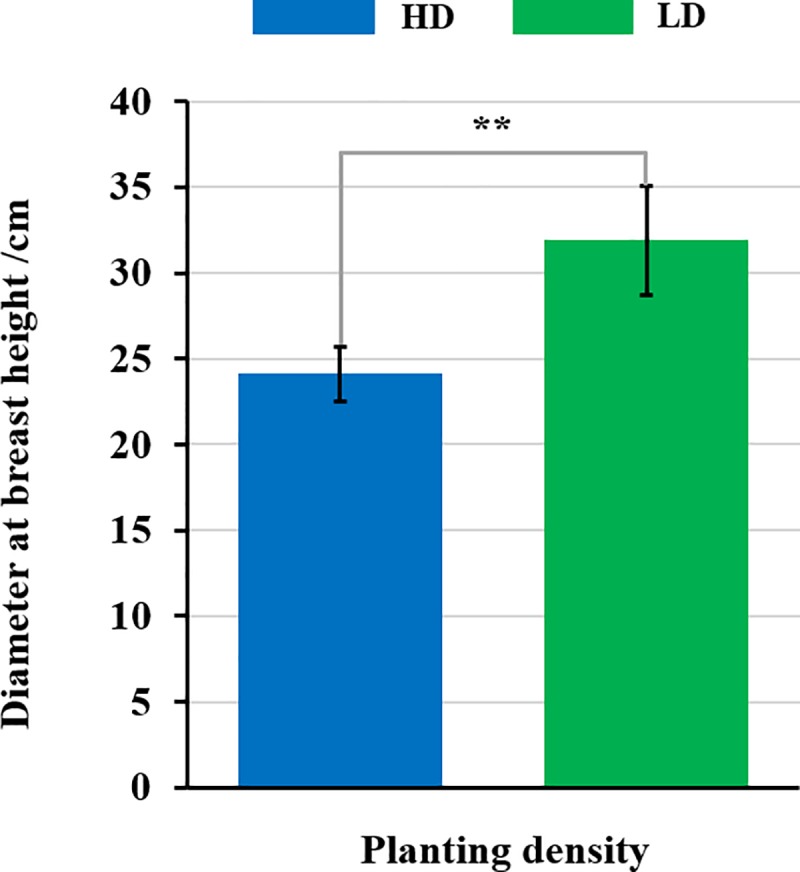
Analysis of Diameter at Breast Height (DBH) growth of poplar under different planting densities.Nine-year-old poplar trees were grown under high (HD) and low (LD) planting density and their DBH was measured.** indicates significant difference at a level of 0.01 by one-way ANOVA using a Duncan t test.